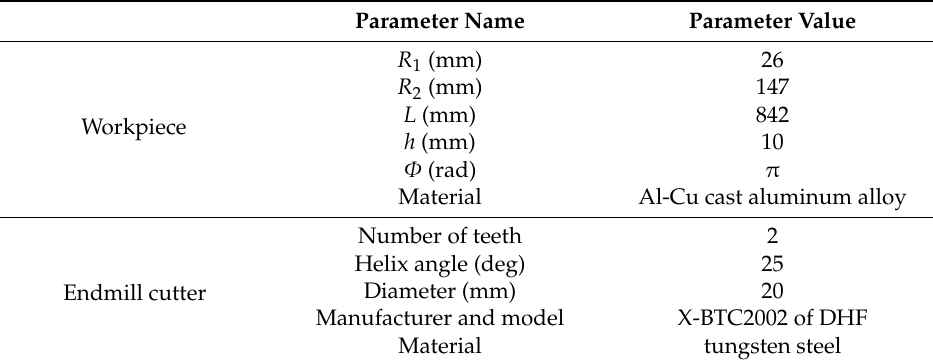
Table 1. Geometric parameters of the workpiece and